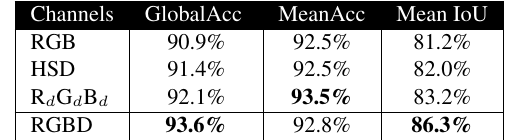
Table 1. Results on semantic labeling in test T1 (using 50% of the dataset for training and 50% for testing)